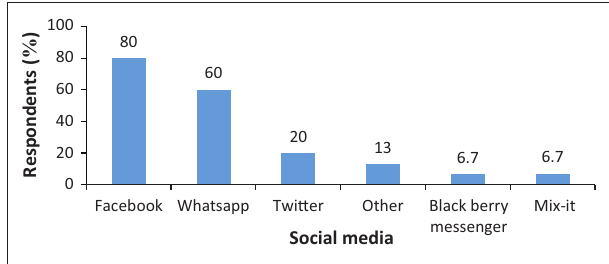
FIGURE 1: Eye health practitioners who reported access to social media (‘Other’ refers to Skype or the